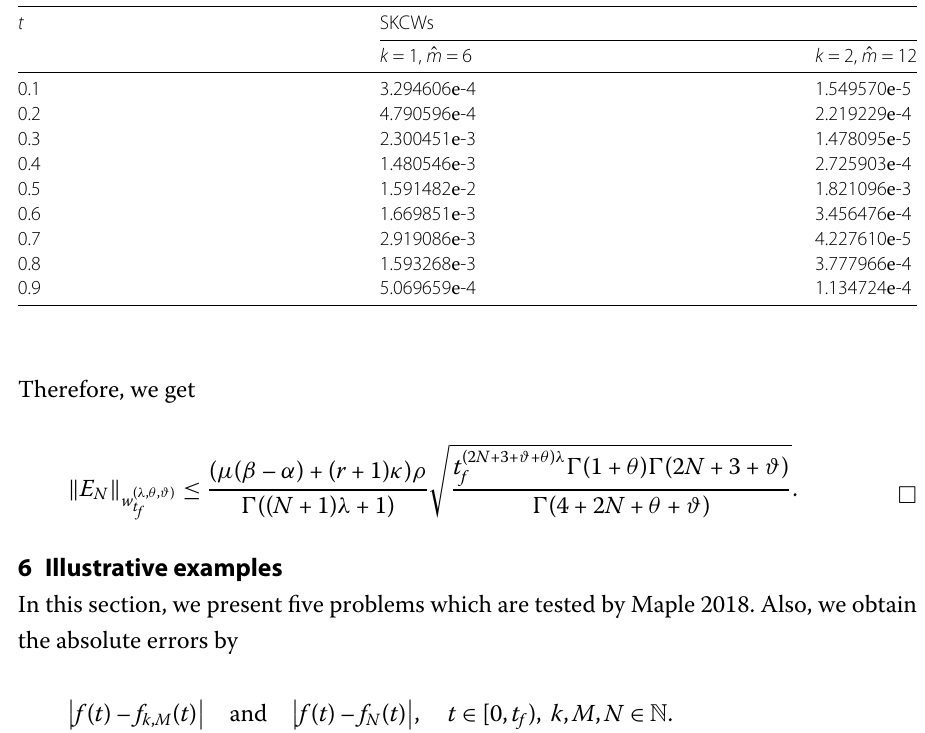
k = 1, ˆ m = 6 k = 2, ˆ m = 12